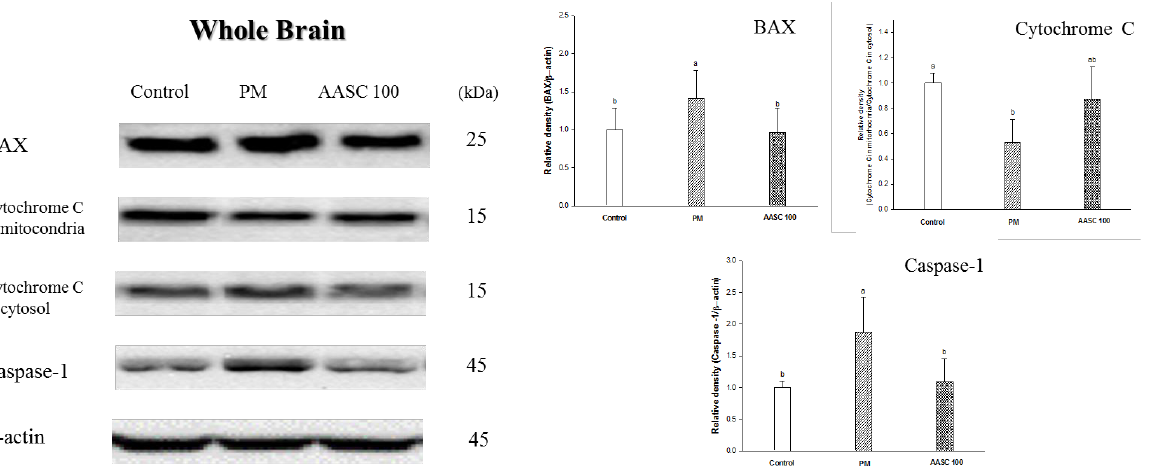
Figure 7. The effect of AASC on proteins related to apoptosis in the brains of mice exposed to PM 2.5 . Results are indicated as mean ± SD (n = 8). Different small letters represent the statistical difference ( p < 0.05) of each group in a high order.